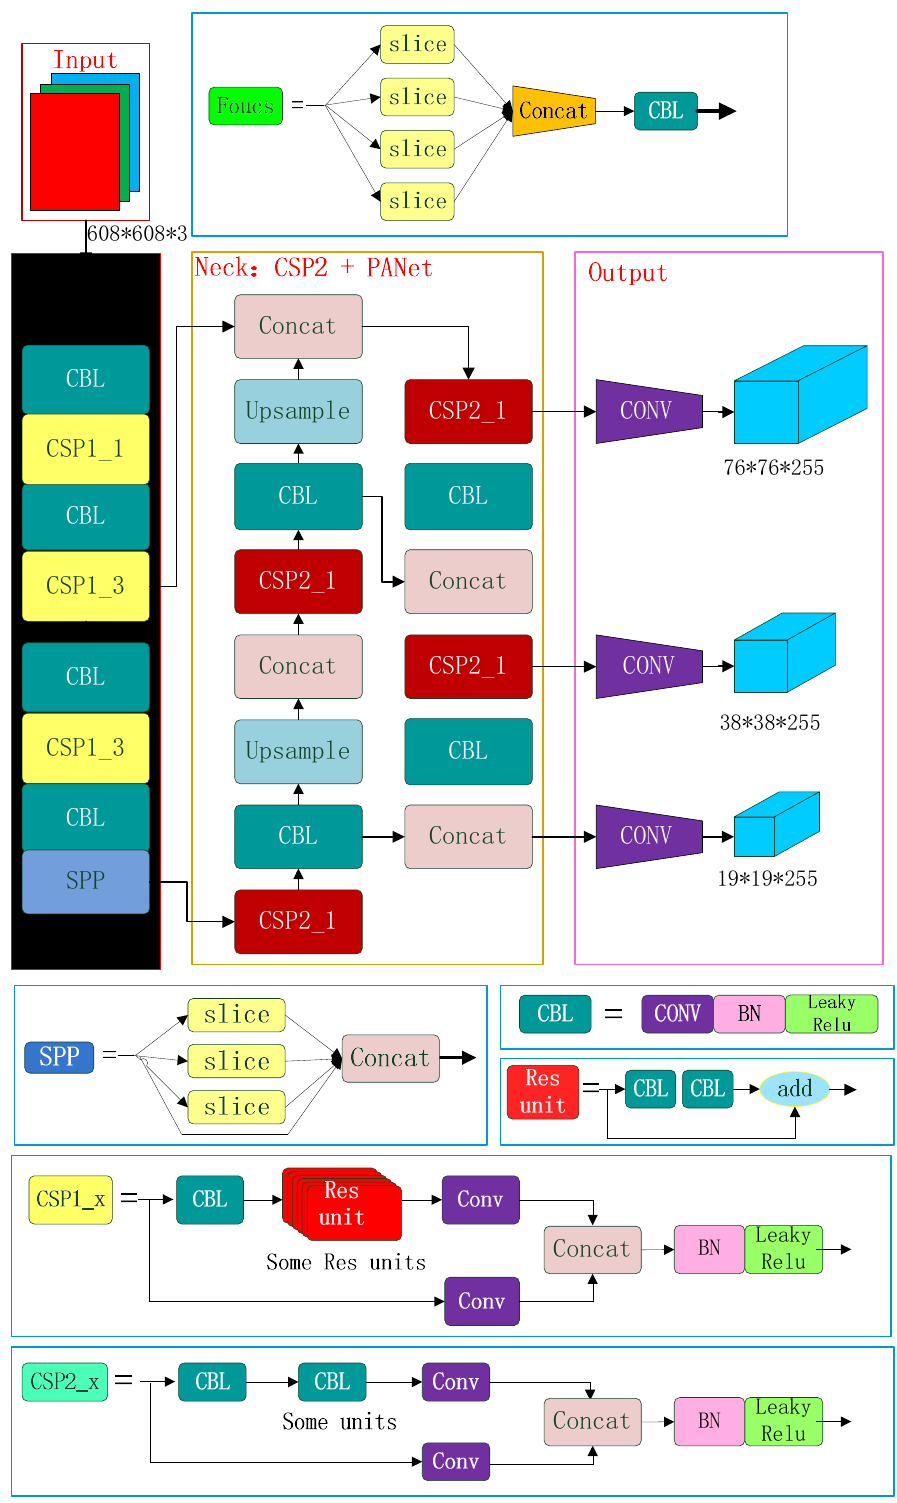
Figure 10. YOLO V5 Structure. In the structure design of insulator defect detection, Focus structure and CSP1 structure are used as the Backbone network, and CSP2 structure and PAN structure are used as the Neck network. The Focus net structure mainly uses slice operation. The Focus structure mainly adopts the slicing operation. The image of W s × H s × 3 is sliced into W S performed on pictures each time when they are read so as to enrich the detected